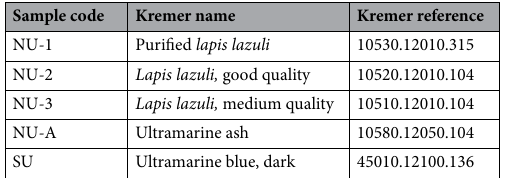
Table 2. Natural and synthetic ultramarine blue pigments employed in this